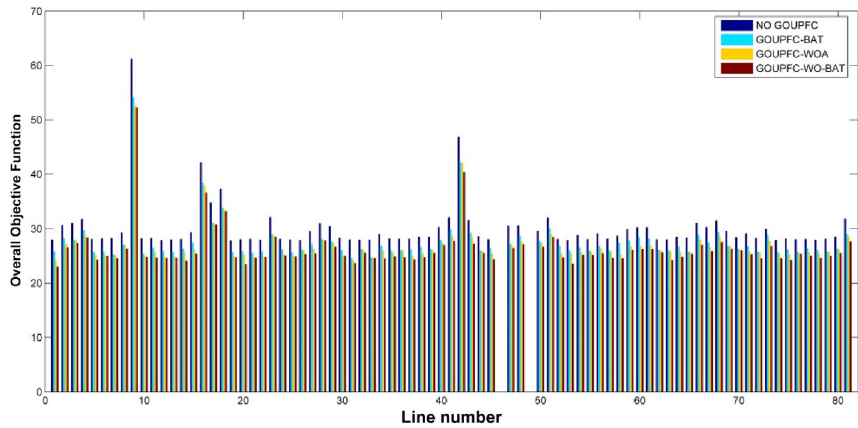
Fig. 7 GOUPFC performance under single contingency without